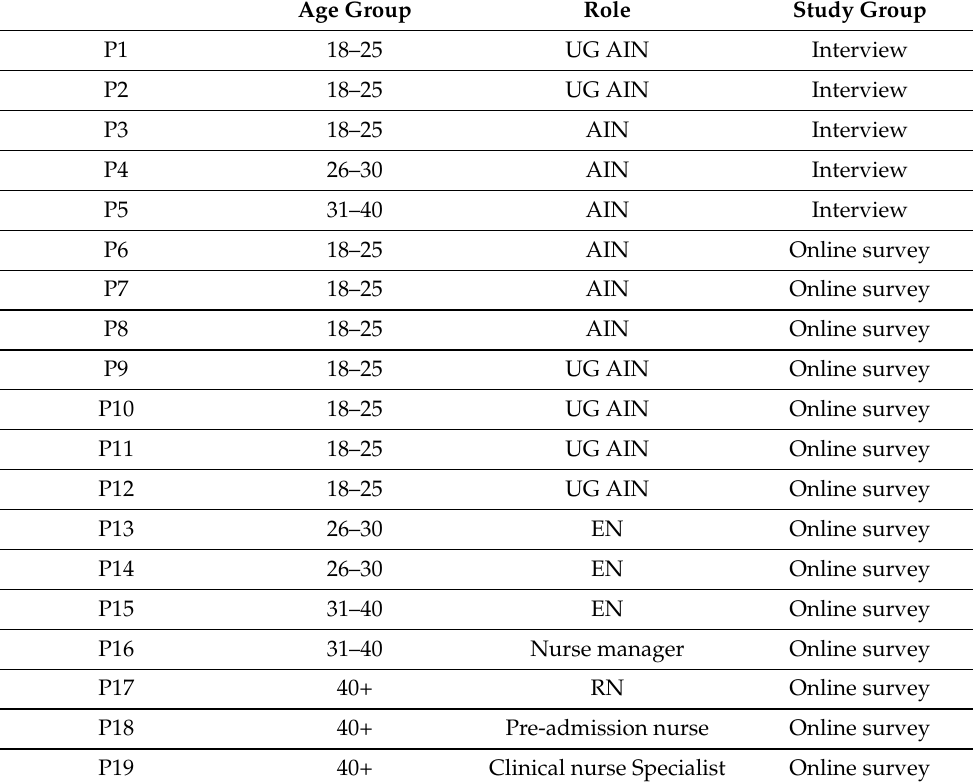
Table 1. Information for each participant: ID, age-group, role (assistant in nursing (AIN), undergrad- uate assistant in nursing (UG AIN) registered nurse (RN), enrolled nurse (EN), and the study group they were involved in. Age